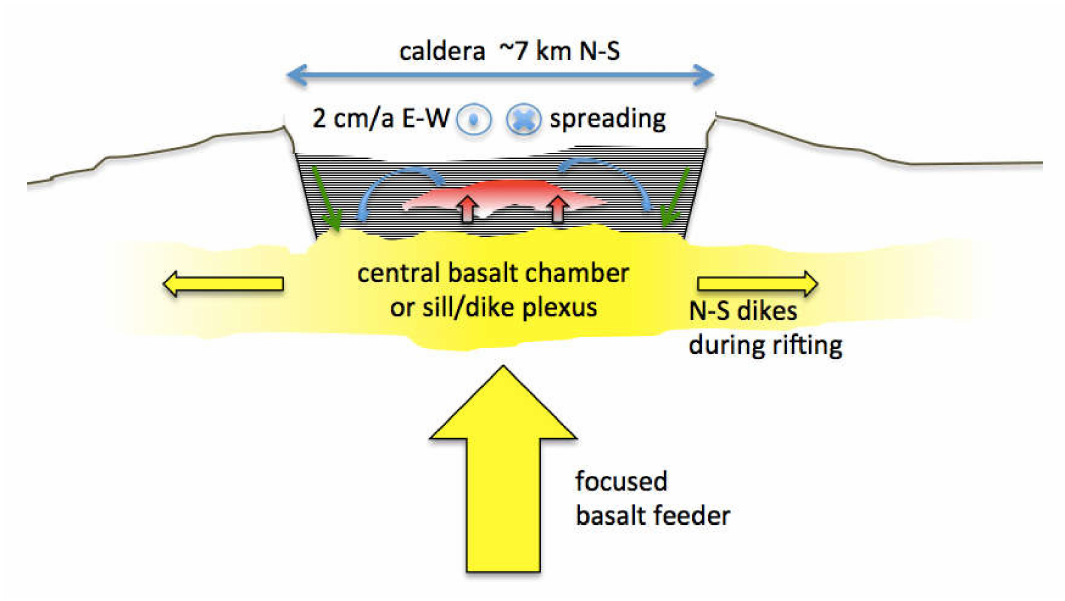
Figure 9. Suggested concept for Krafla shield and caldera. A basaltic magma plume beneath the rift is responsible for building the shield and maintaining a large and relatively shallow basaltic magma chamber. This chamber may be a plexus of dykes and sills rather than an oblate bladder. During rifting events, the magma accumulation feeds dikes that travel tens of kilometers to the north and south, deflating and contributing to caldera subsidence in the process. Central eruptions and intrusions of basalt and more silicic magmas comprise the caldera fill, which is hydrothermally altered in this crucible and gradually fed downward to the basaltic hearth. Partial melting ensues, probably continuously dribbling rhyolitic melt upward to its level of neutral buoyancy at about 2 km depth. If the input is insu ffi cient, only felsite sills are produced, but if more vigorous, a homogeneous convecting rhyolite magma body is established. It is stable for long periods of time, but can be expelled if a massive influx of basaltic magma occurs below it during a major rifting event. Undisturbed, the shallow rhyolite contributes only a portion of the thermal output of the caldera, but it represents a massive concentration of latent heat of crystallization at shallow depth that can be accessed if the MHB above it is penetrated by drilling, allowing fluid to invade and fracture the magma and near-magma